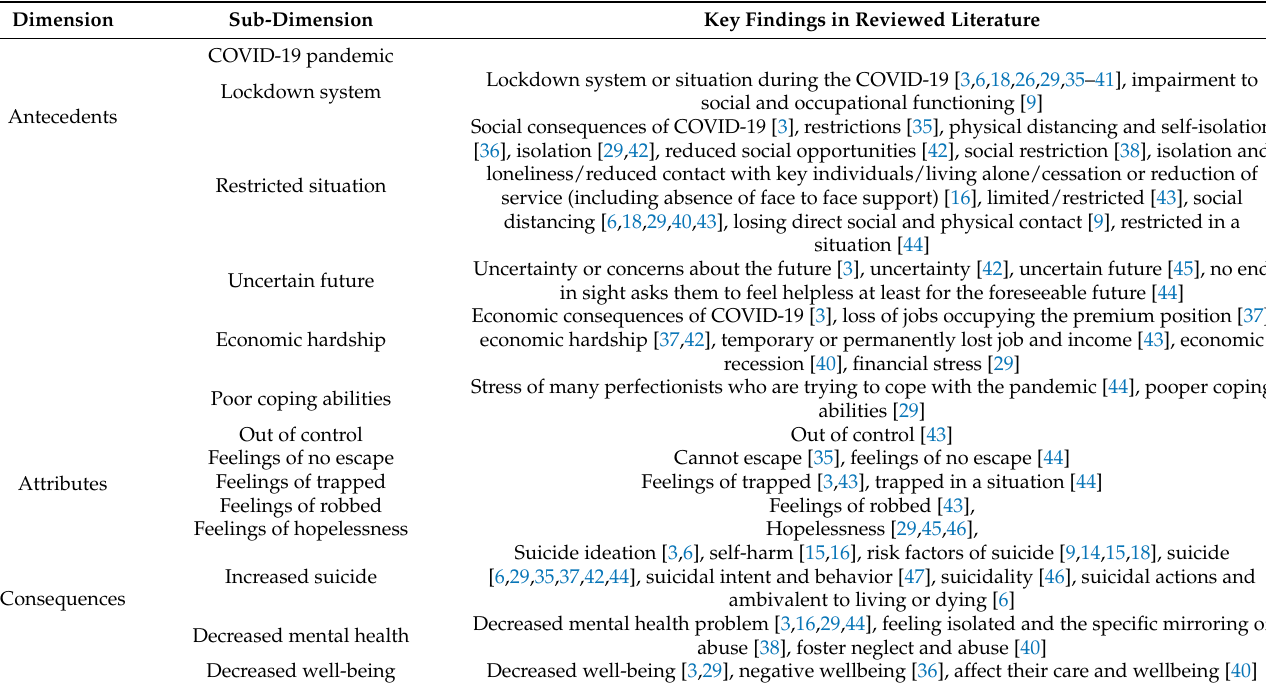
Table 1. Antecedents, attributes and consequences of feelings of entrapment. Dimension Key Findings in Reviewed